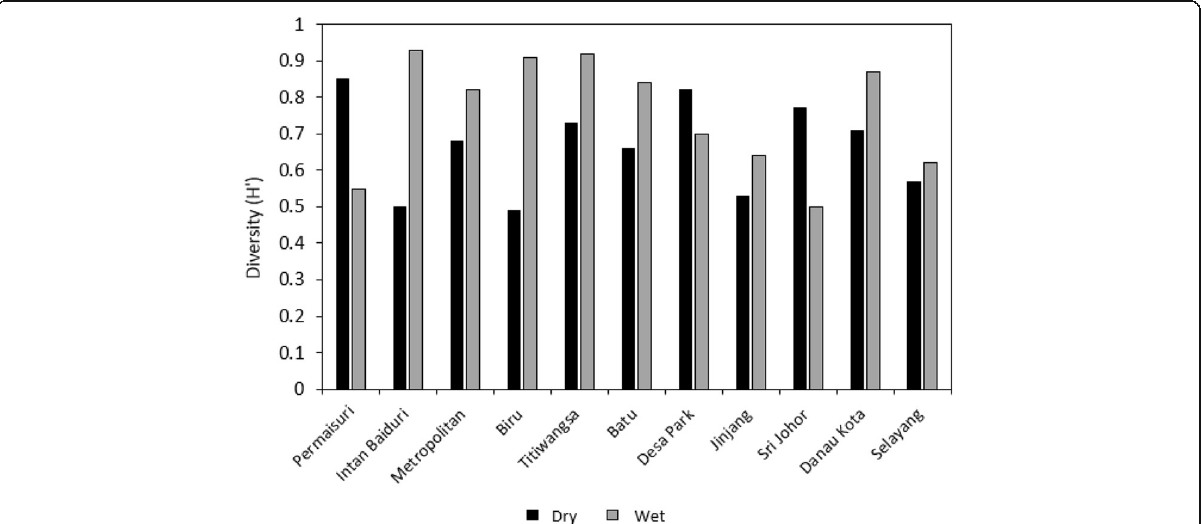
Fig. 6 Rotifer species diversity index ( H ′ ) during dry and wet seasons in studied lakes and ponds